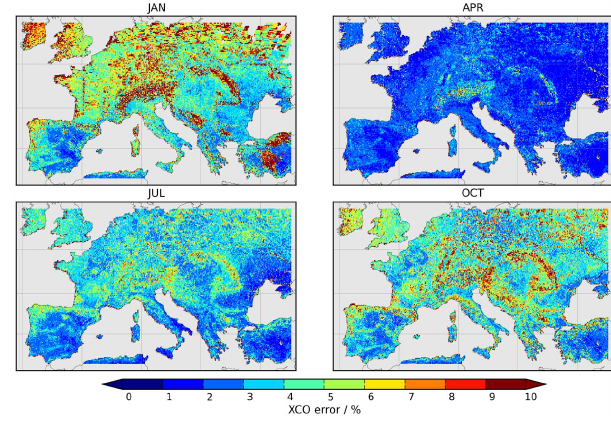
Figure 8. Relative XCO noise error among the European trial en- semble expected from G3E for the months January (JAN), April (APR), July (JUL), and October